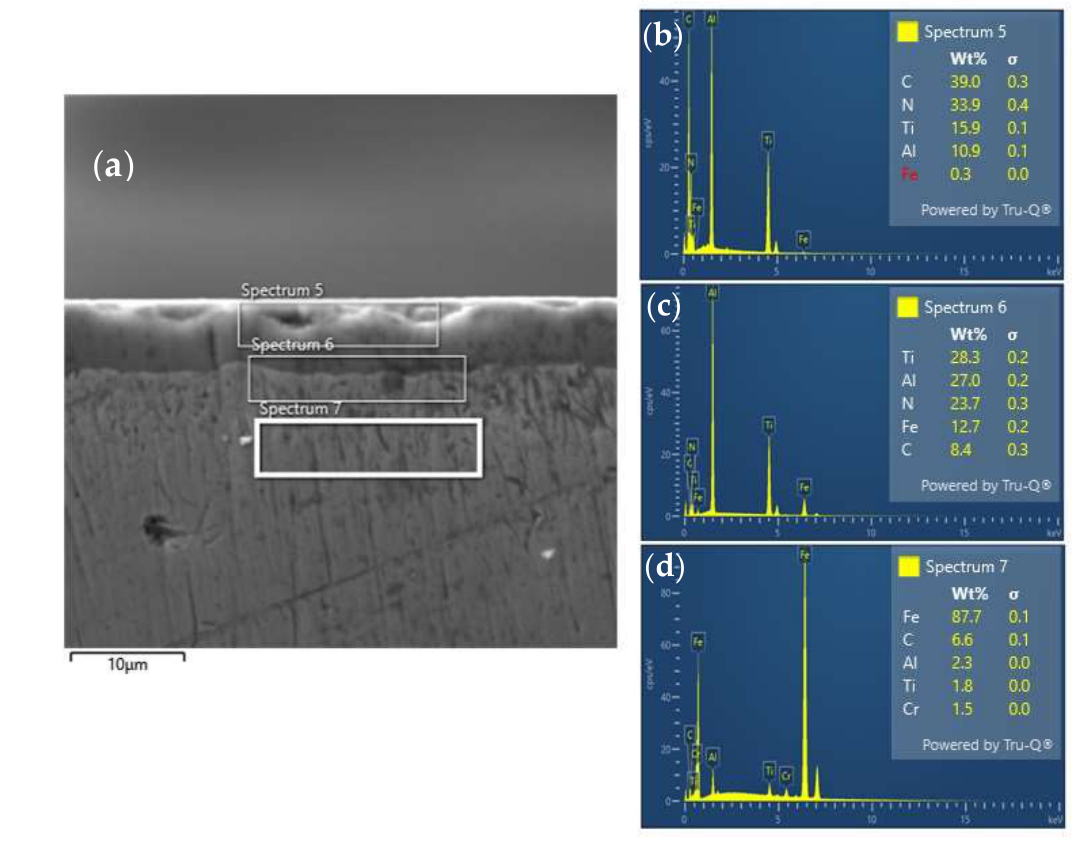
Figure 3. Selected site ( a ) for area analysis of the coating with the EDS recording of individual elements: ( b ) EDS spectra of TiAlCN coatings, ( c ) EDS spectra of TiAlCN layer and partly of the substrate, ( d ) EDS spectra of substrate.